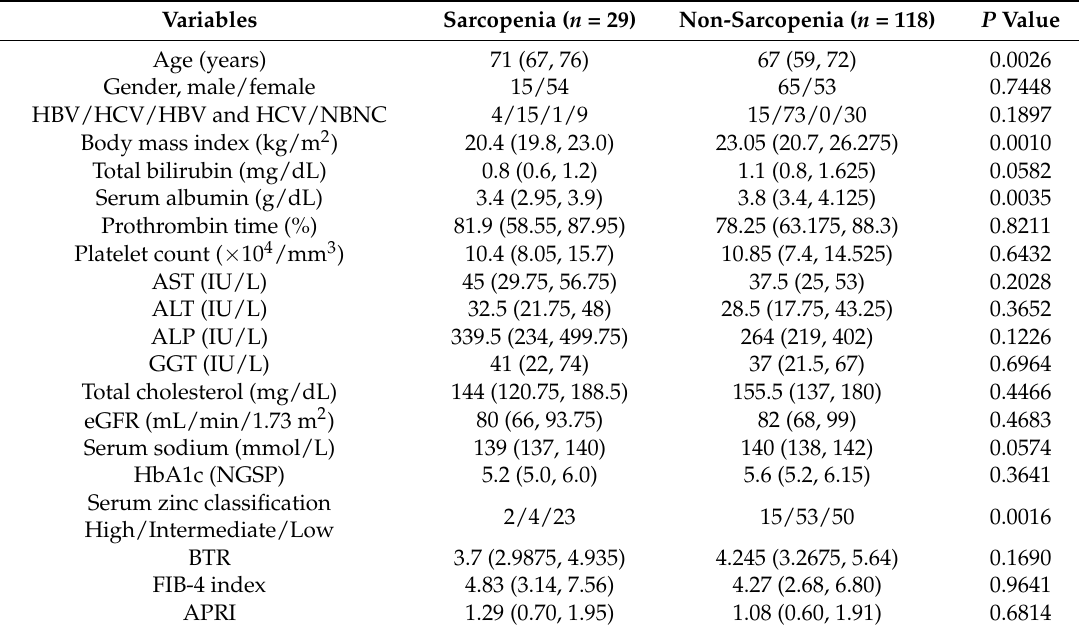
Table 4. Univariate analyses of factors associated with the presence of sarcopenia for LC cases ( n = 147). Variables Sarcopenia ( n = 29) Age (years) Gender, male/female HBV/HCV/HBV and HCV/NBNC